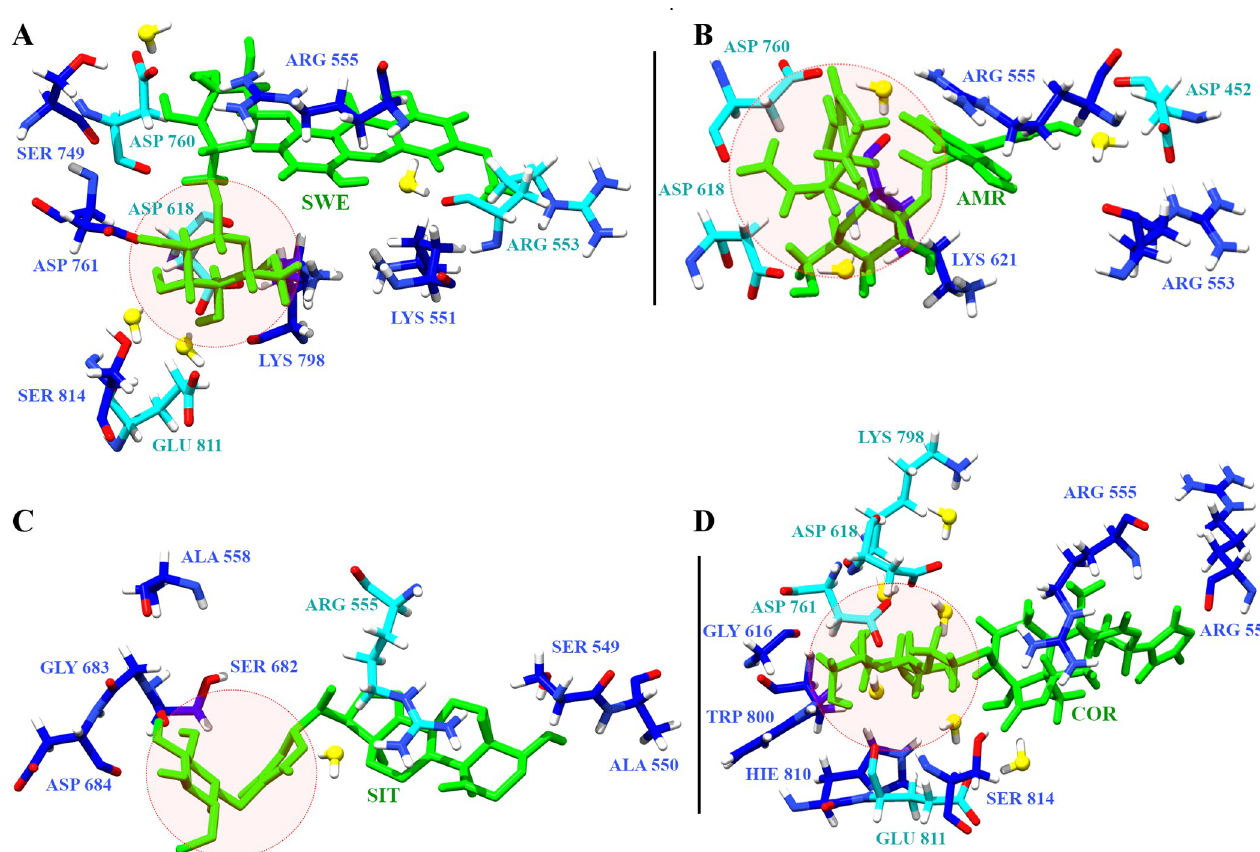
Fig 8. Phytochemical interaction partners. Snapshots of RdRP residues forming hydrogen bonds (blue) and water mediated (cyan) interactions with (A) SWE, (B) AMR, (C) SIT and (D) COR. The red circle denotes the interacting glucose moieties of the phytochemicals.